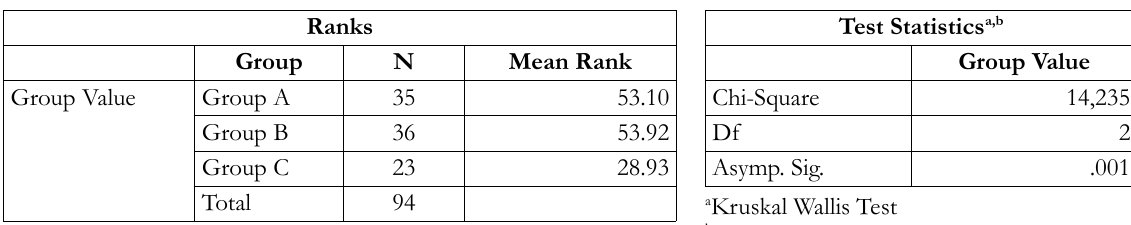
Table 6. data on the results of the Kruskal Wallis Test